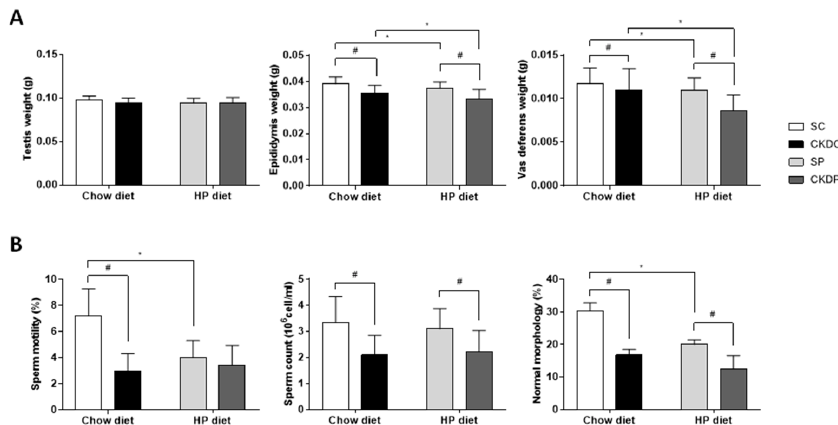
Figure 2. ( A ) Testis, epididymis, and vas deferens weight, and ( B ) parameters of semen quality in high phosphorus diet-fed mice with or without CKD induction. Data are expressed as the mean ± SD. # indicates a significant difference between the sham-operated and CKD-induced groups (SC vs. CKDC and SP vs. CKDP); * indicates a significant difference between the chow diet and high phosphorus diet-fed groups (SC vs. SP and CKDC vs. CKDP).